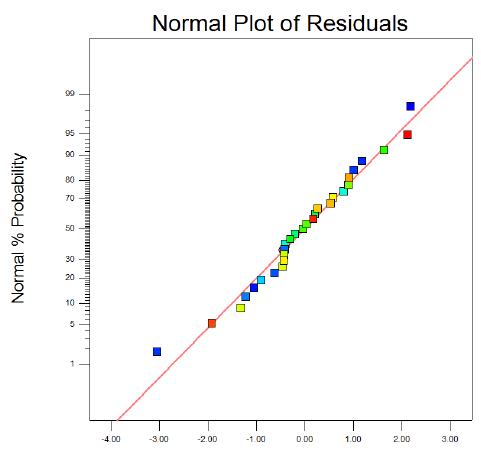
Figure 9. The external studentized residuals.